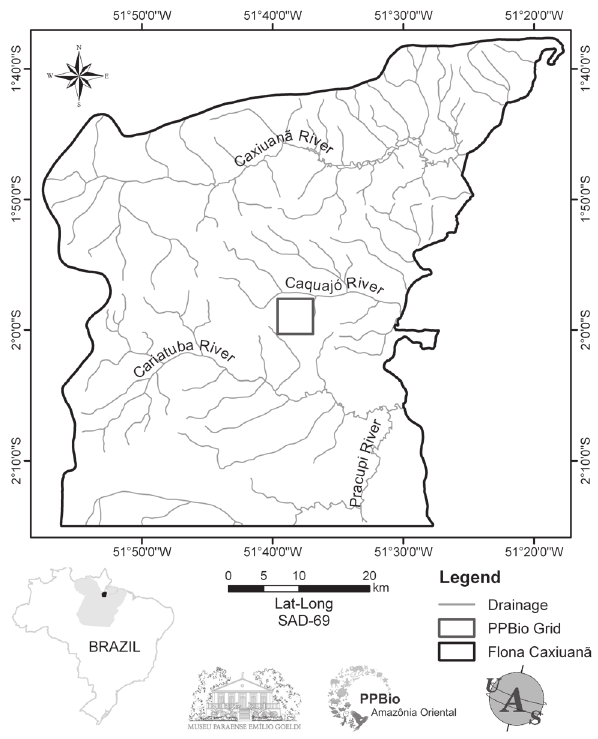
Figure 1. Location of the PPBio research site in the Floresta Nacional (Flona) de Caxiuanã, state of Pará, Brazilian